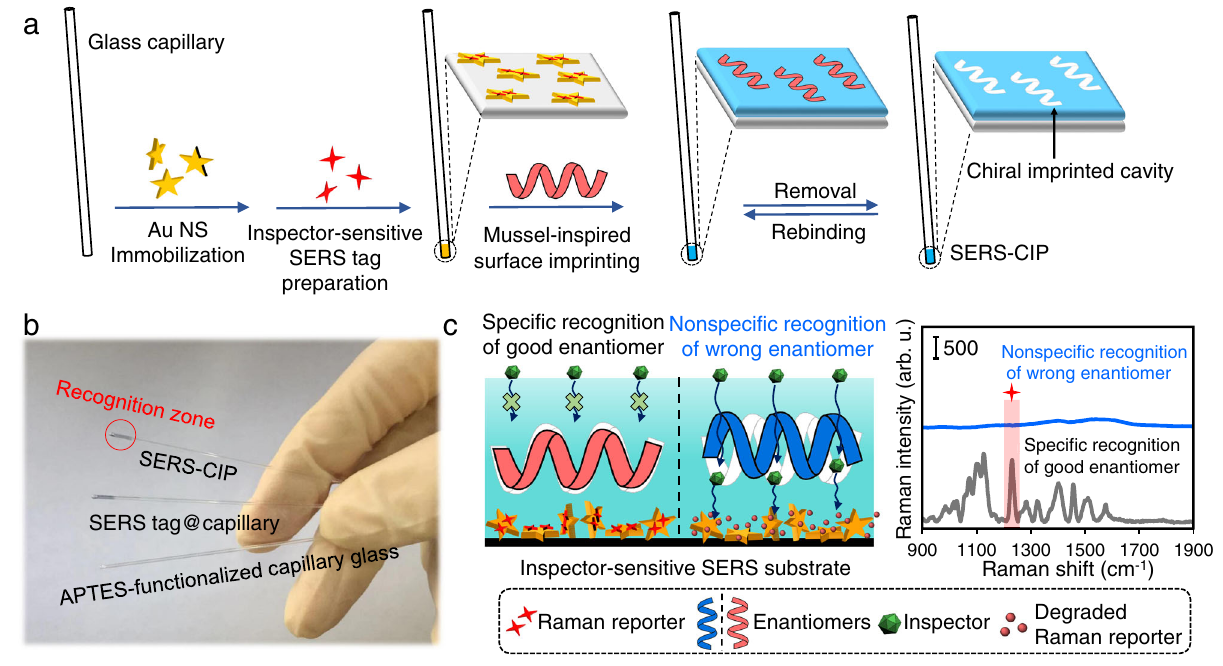
Fig. 1 | The SERS-CIPconstruction and principle ofIRM. a Schematicillustration of the SERS-CIP construction. b Photo images of APTES-functionalized